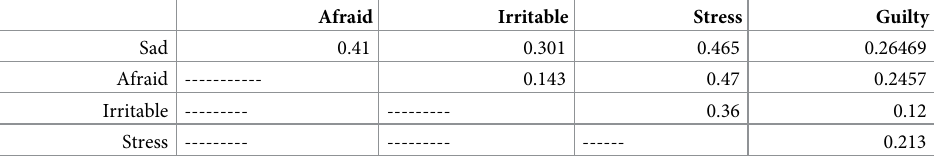
Table 3. Correlations across models’ error